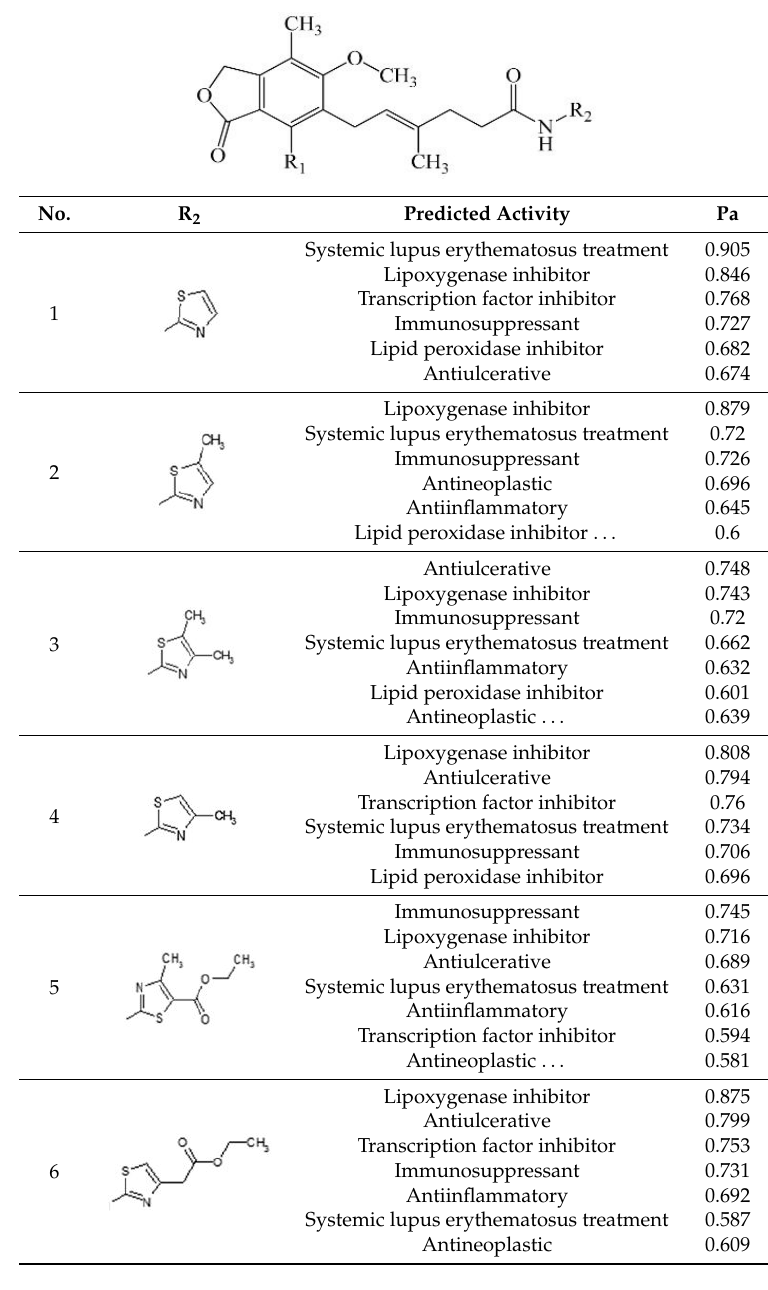
Table 2. Prediction of the biological activity spectra of the designed